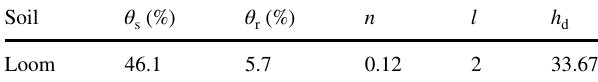
Table 3 Soil parameters for the model